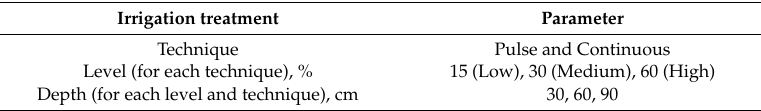
Table 1. Treatment distribution in the experimental